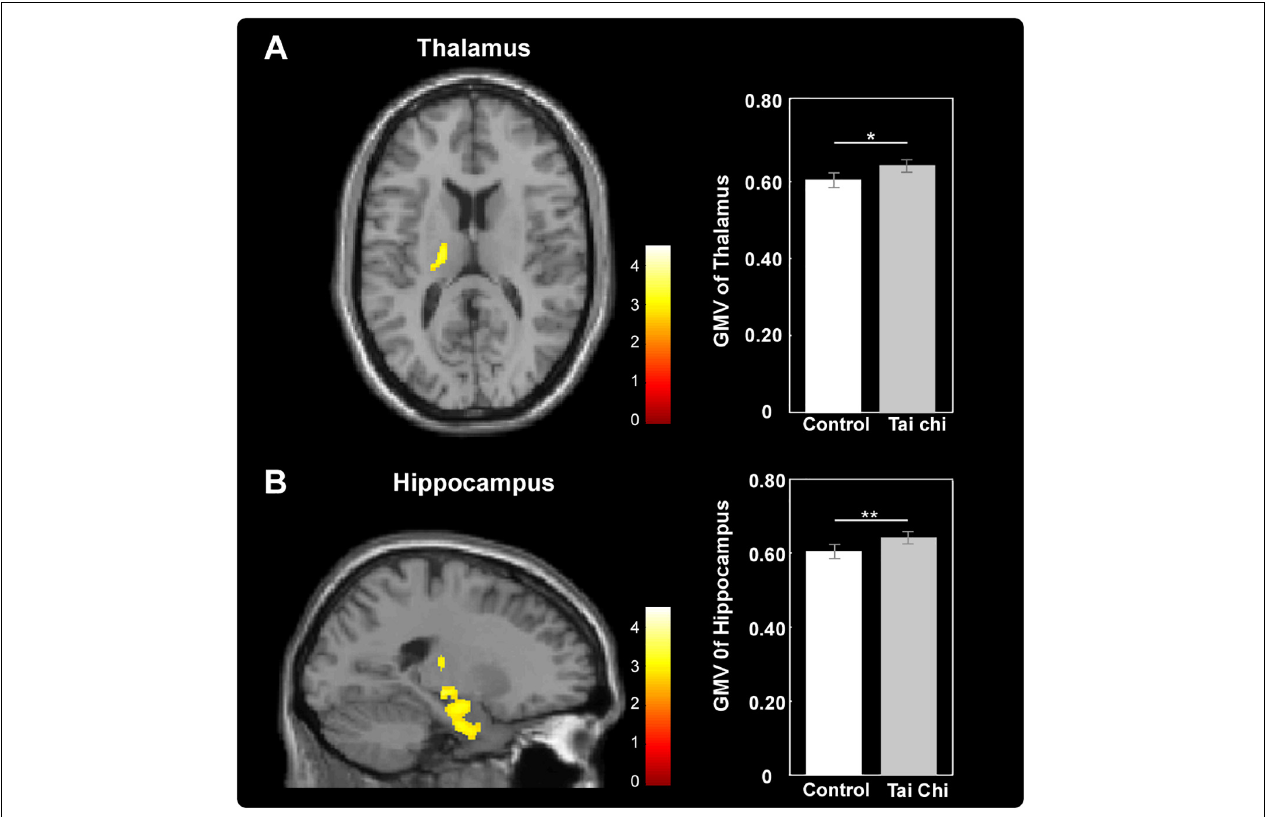
FIGURE 2 | Differences in GMV between Tai Chi group and control group. Tai Chi group showed larger GMV in the left thalamus (A) and left hippocampus (B) . Cluster level, p < 0.05, FWE corrected; voxel level, p < 0.005, uncorrected. Error bars indicated one standard error. ∗ p < 0.05, ∗∗ p < 0.01.